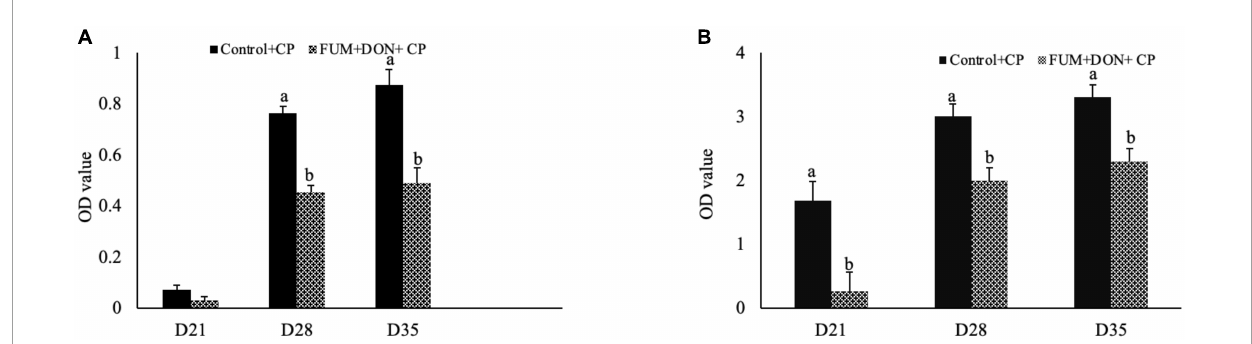
FIGURE1 Effect of subclinical fumonisins (FUM) and deoxynivalenol (DON) contamination on bile anti-Clostridium IgA content. Broilers were fed control or mycotoxin (FUM 3 mg/kg diet + DON 4 mg/kg diet). All birds received 1 × 10 8 CFU/bird of C. perfringens on d 19 and 20. At 1, 7, and 14 days after infection, bile was analyzed for anti- C. perfringens specific IgA (A) and total IgA (B) by ELISA and expressed as optical density (OD). Bars (+SEM) with “a” and “b” superscript differ significantly ( P <